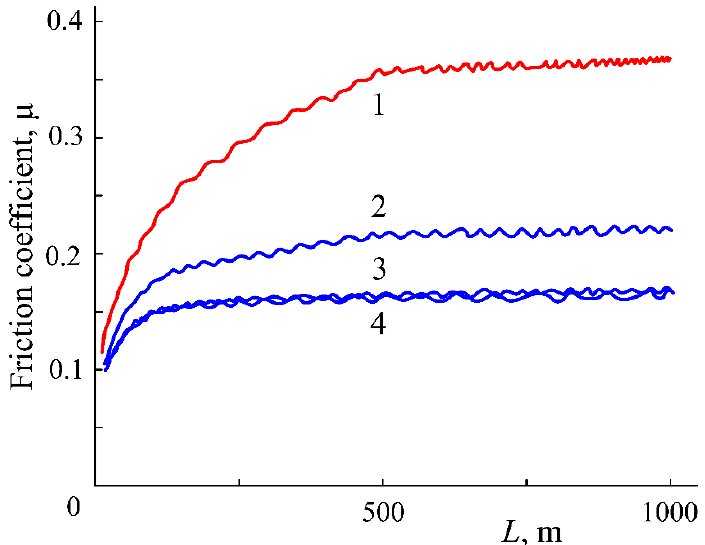
Figure 6. Dependence of the friction coefficient µ on the sliding distance L for an untreated substrate (curve 1) and substrates irradiated with 30-keV argon atoms for 30 (curve 2), 60 (curve 3) and 90 s (curve 4).